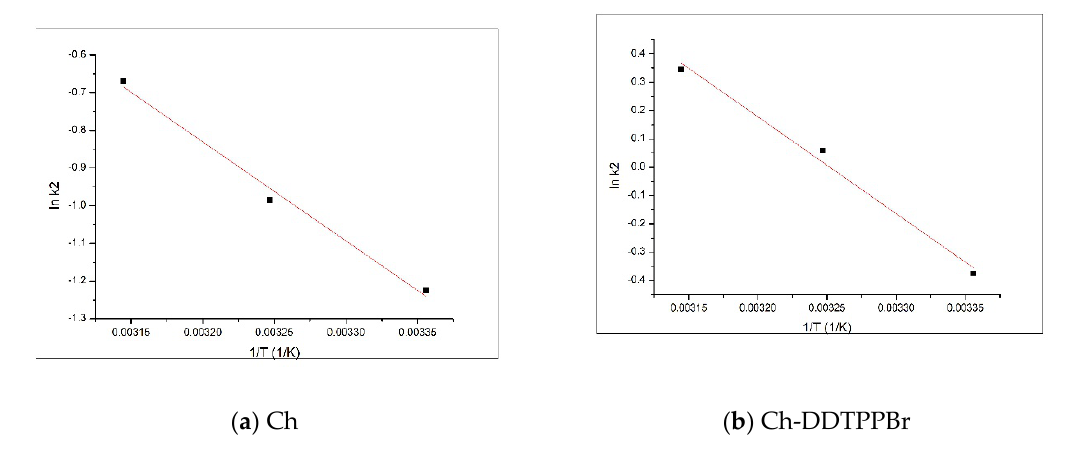
Figure 9. Activation energy ( a ) Ch; ( b ) Ch-DDTPPBr.